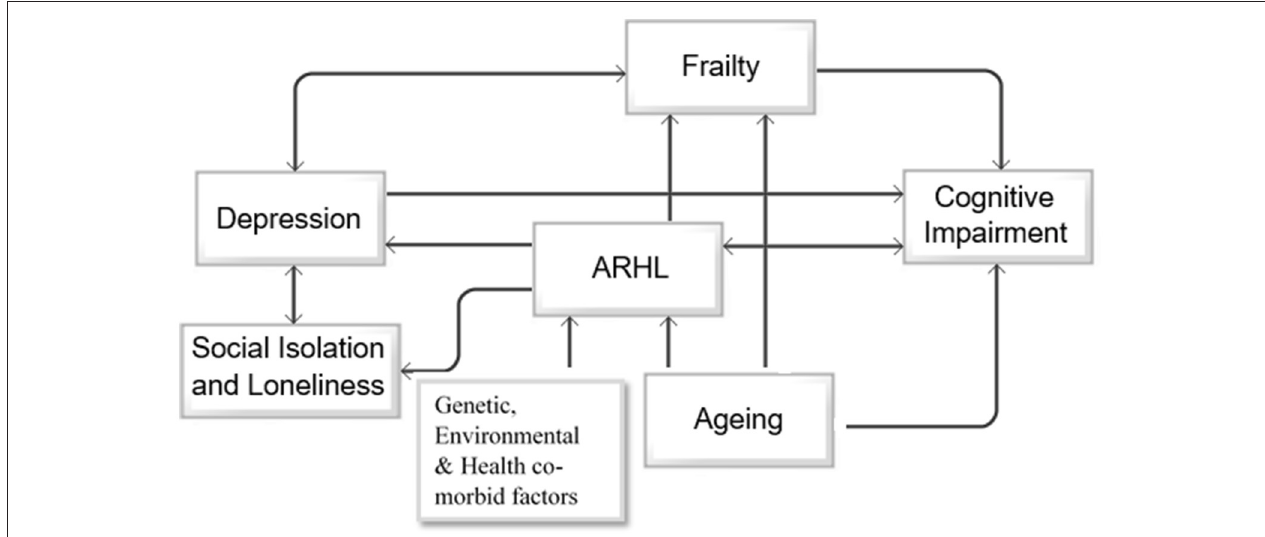
FIGURE 2 | Directional associations between aging, ARHL, depression, social isolation and loneliness, frailty and cognitive impairment. The schematic diagram represents the unidirectional association between aging, age-related hearing loss (ARHL), and cognitive impairment, and unidirectional association between ARHL and social isolation, depression and frailty, and bidirectional association between depression and social isolation and depression and frailty.